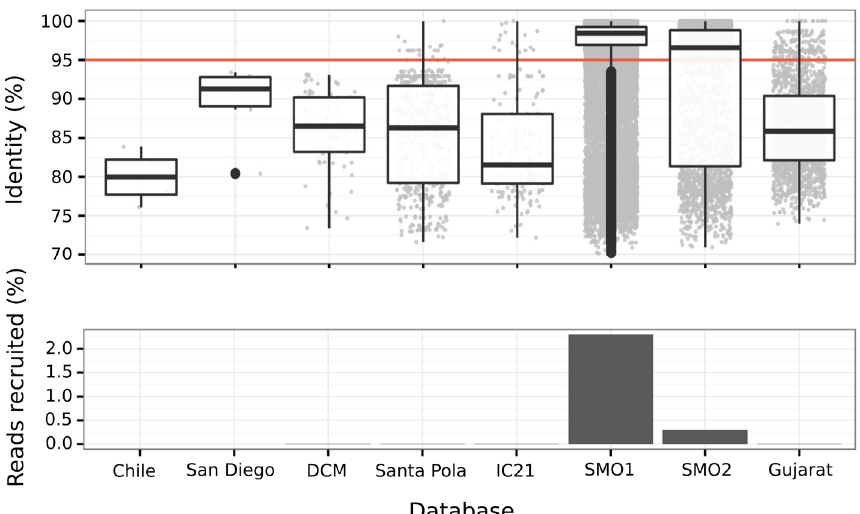
Figure 6. Percentage of metagenomic reads from diverse hypersaline environments recruited and their identity to the genomic sequence of bin 1. Saltern databases used were: Chile, corresponding to a crystallizer pond with 34% salinity from Cáhuil Lagoon (Chile) [58]; San Diego, resulting from the combination of the datasets obtained from Guerrero Negro solar saltern (Baja California Sur, Mexico) [24]; Santa Pola, as the combination of the metagenomes obtained from Santa Pola saltern (Alicante, Spain) [22,23] and IC21, corresponding to the metagenomic database of a concentrator pond with 21% salinity from Isla Cristina saltern (Isla Cristina, Huelva, Spain) [56]. DCM corresponds to a Mediterranean marine sample with a total salt concentration of 3.5% [57]. Saline soils are represented by the Odiel saltmarshes databases (SMO1 and SMO2) and the metagenomic datasets from soils located in the Great Rann of Kutch (Gujarat, India), combined in Gujarat [19].